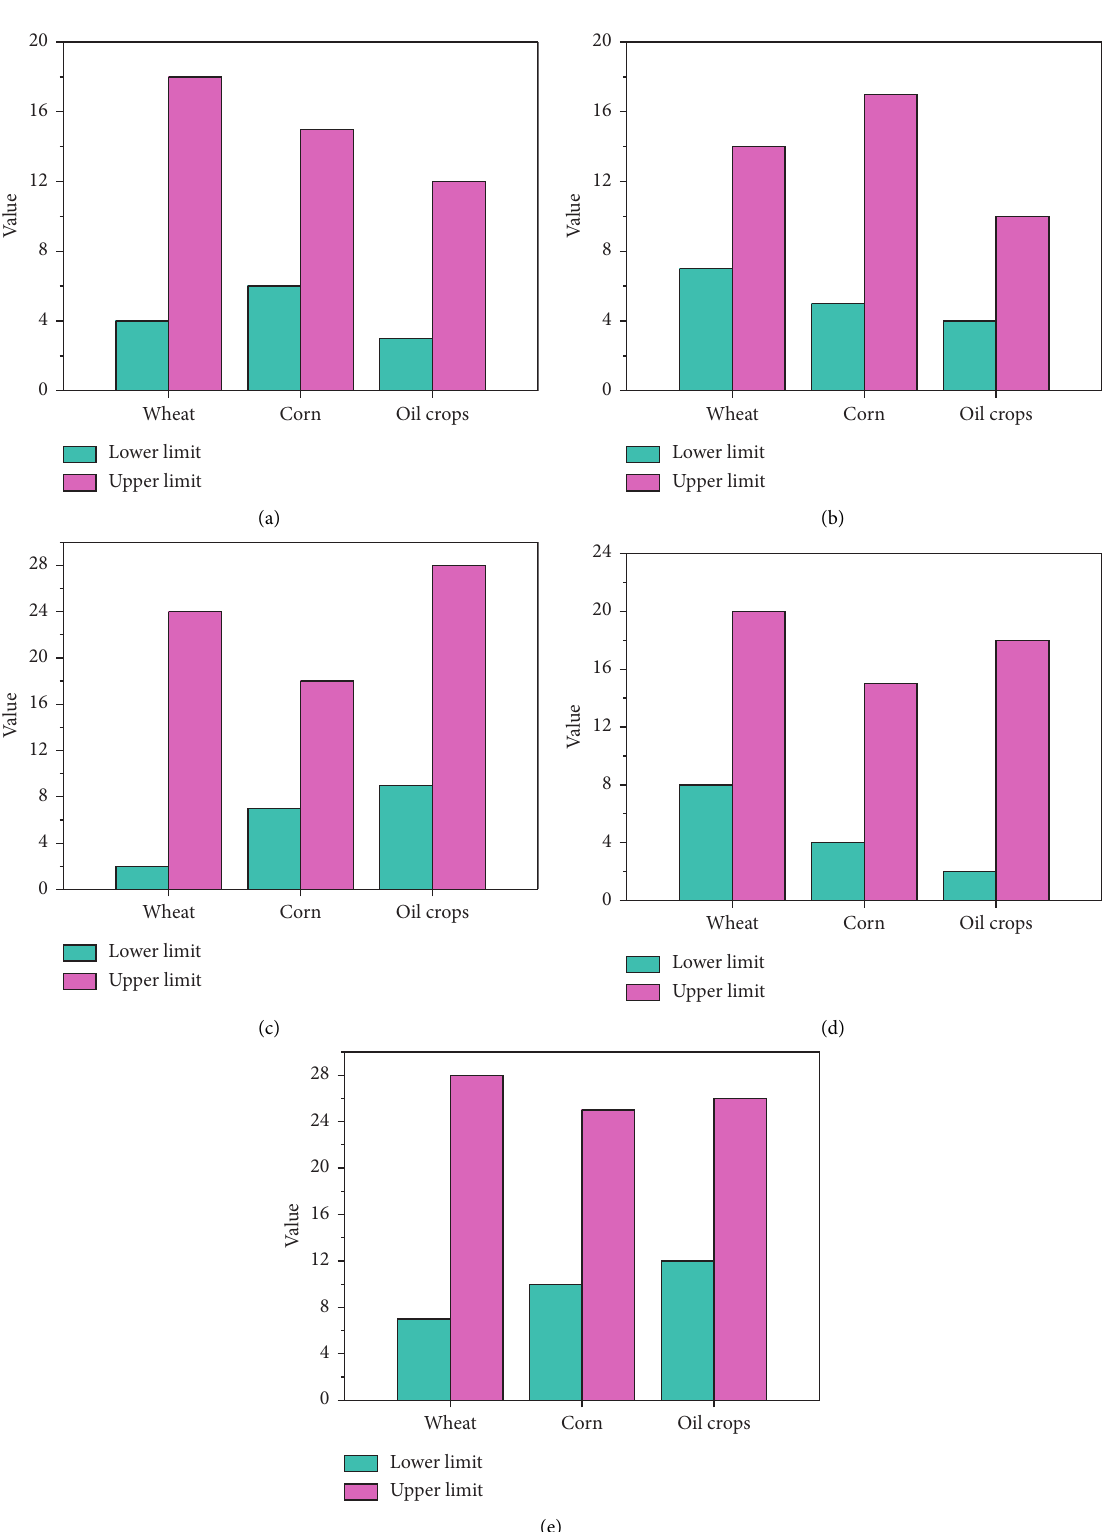
Figure 5: The upper and lower limits of the function under different membership degrees: (a) Zhongyuan district, (b) Jinshui district, (c) Erqi district, (d) Gongyi city, and (e) Xinzheng